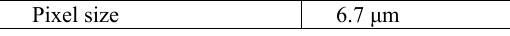
Figure 6. Overlaid CE-2 and CE-3 DOMs. (a) Base DOM from No.0236 track of CE-2, (b) Overlaid DOMs after bundle adjustment and absolution orientation.